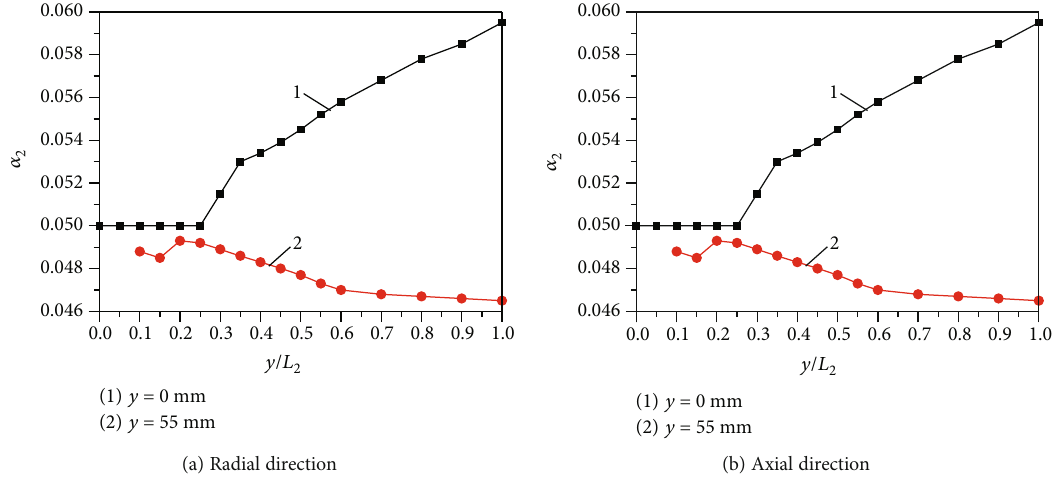
Figure 8: Soot concentration distribution of the DPF in the capture